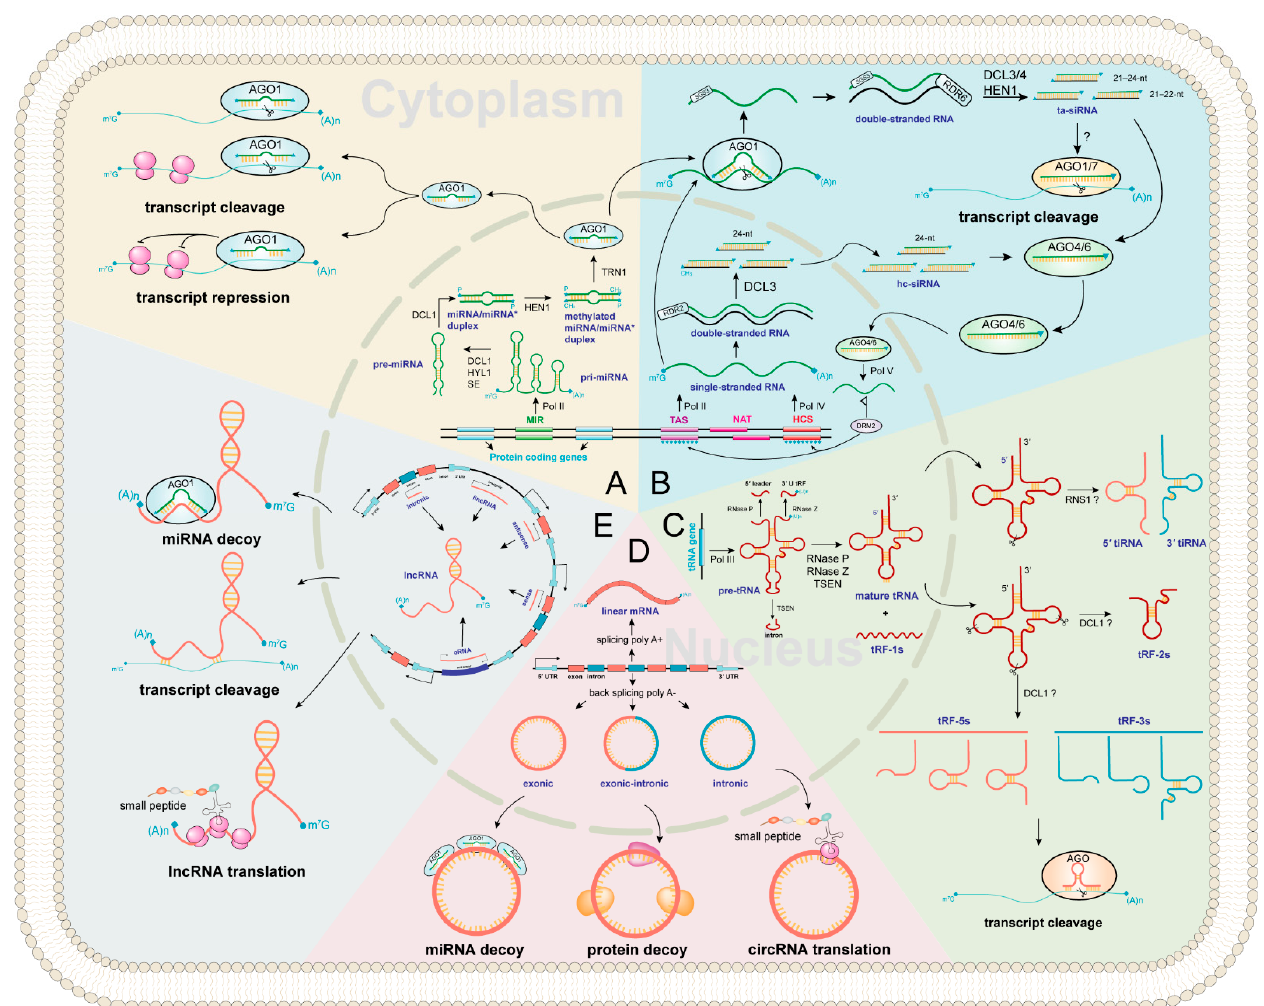
Figure 2. Regulator ncRNAs biogenesis landscape and functions in plants. The inside of the circle represents the nucleus, and the outside represents cytoplasm. All ncRNAs types are marked in purple. The background of each color represents biogenesis and functions of ( A ) miRNA; ( B ) siRNA; ( C ) tsRNA; ( D ) circRNA; ( E ) lncRNA, respectively.